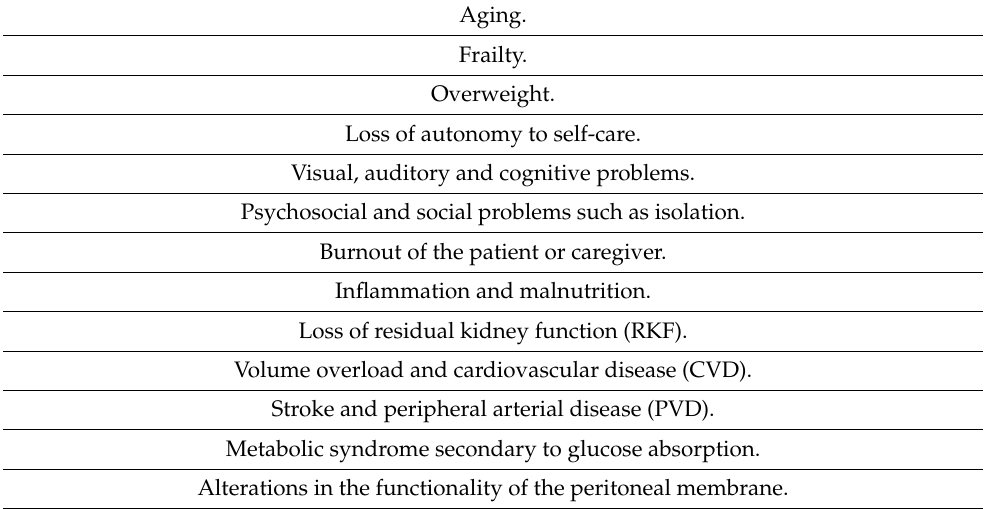
Table 4. Barriers that may arise over time patients with PD.